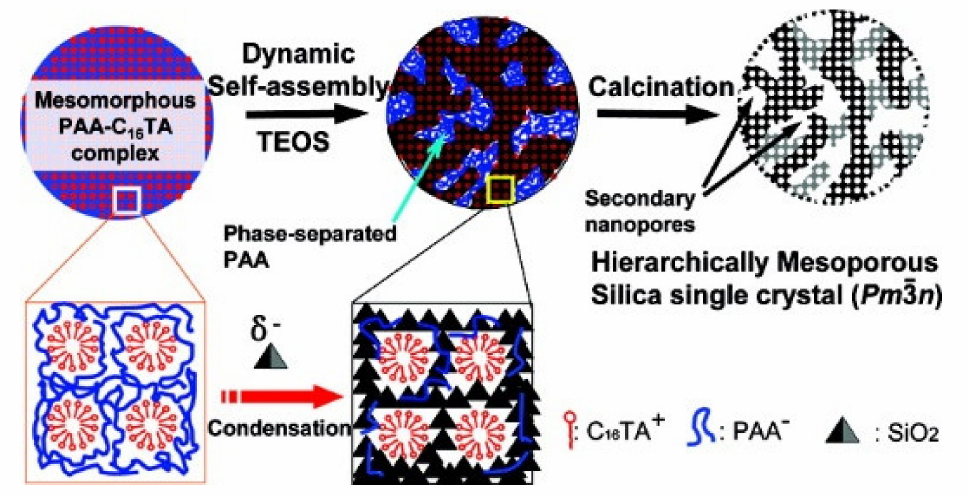
Figure 6. Schema of the synthesis of hierarchic SBA-1 silica with the use of PAA / C 16 TAB complex. Reprinted with permission from Reference [71]. Copyright (2010) American Chemical